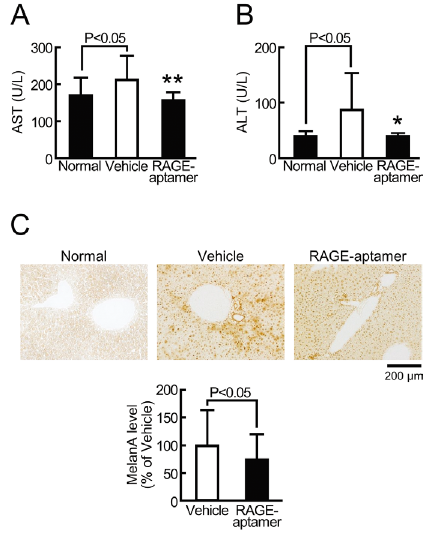
Figure 5. Effects of RAGE-aptamer on (A) AST, (B) ALT and (C) hepatic immunostain- ing of melanA in nude mice. (C) Upper panels show representative photographs of immunostaining. Lower panel shows quantitative data. * and **, p < 0.05 and p < 0.01 compared with the values of vehicle-treated mice,